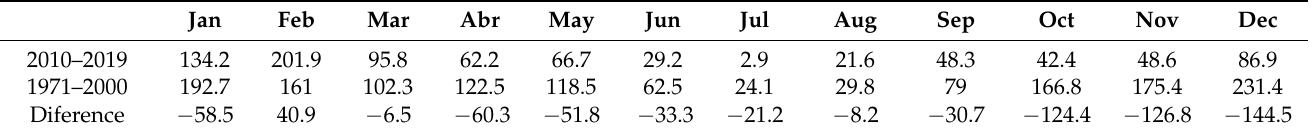
Table 1. Comparative analysis between the monthly precipitation presented in Figure 3 and the climatic normal values for the period 1971–2000 (data for the normal period 1971–2000 available on https://www.ipma.pt/pt/oclima/normais.clima/1971-2000/#23, accessed on 9 July 2021).